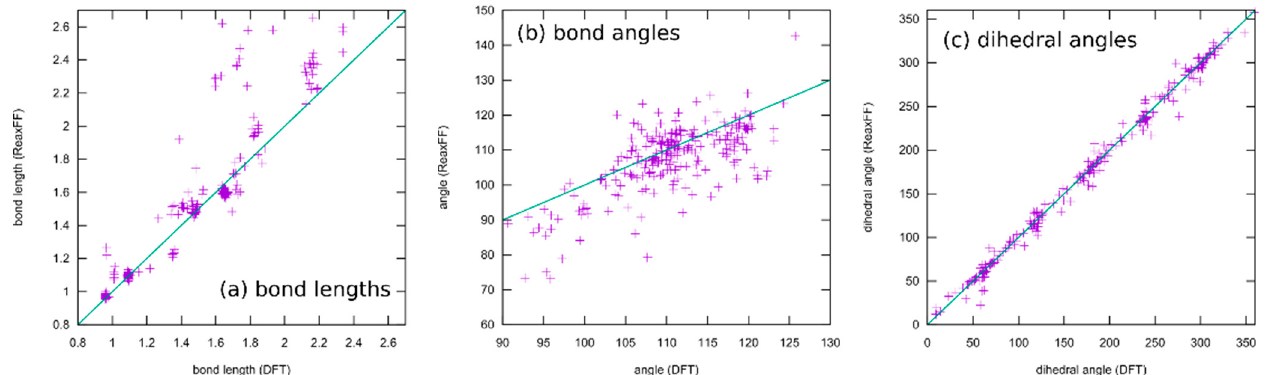
Figure 2. Result of the OGOLEM ReaxFF parameter optimization for the geometry part of the training set. Shown are the deviations between the ReaxFF and DFT reference for all included coordinates, bond lengths ( a ), angles ( b ) and dihedral angles ( c ), where the ReaxFF values originate from geometry-optimized structures with the optimized force field (Supplementary Material, Figure S1).